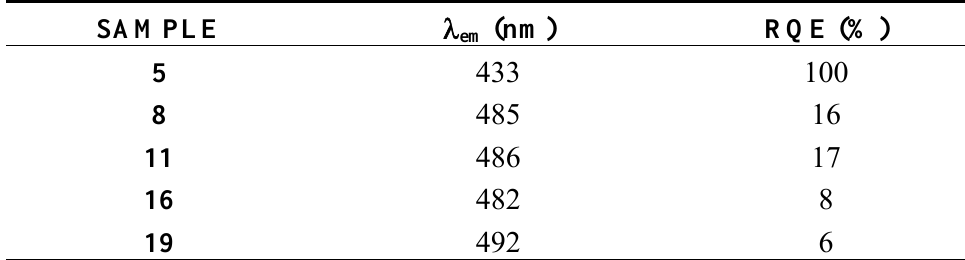
Table 2. Spectral characteristics of 5 and 8 , 11 , 16 and 19 excited at 365 nm (RQE = relative quantum efficiency measured with respect to 5